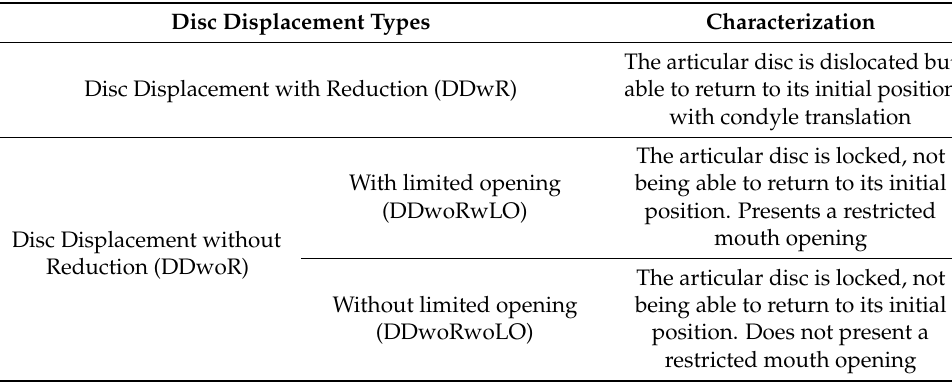
Table 1. Different types of Disc Displacement